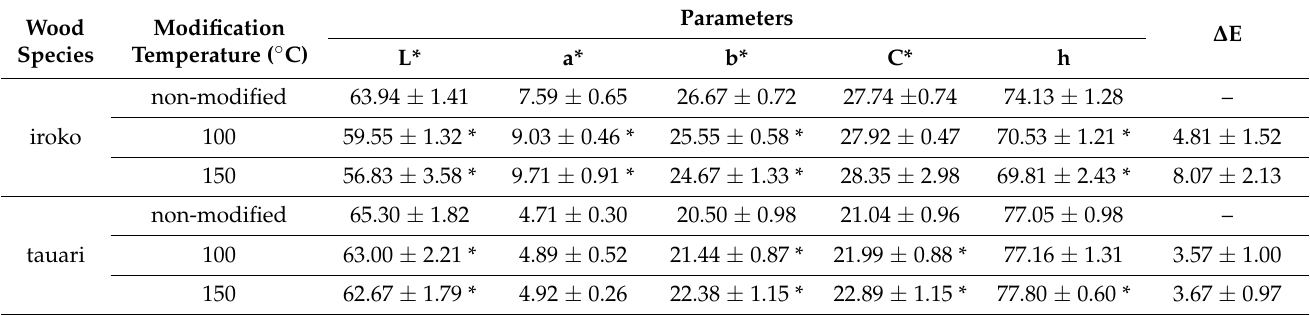
* Statistically significant differences within the same species, based on the t-test ( p ≤ 0.05; control group, non-modified wood).